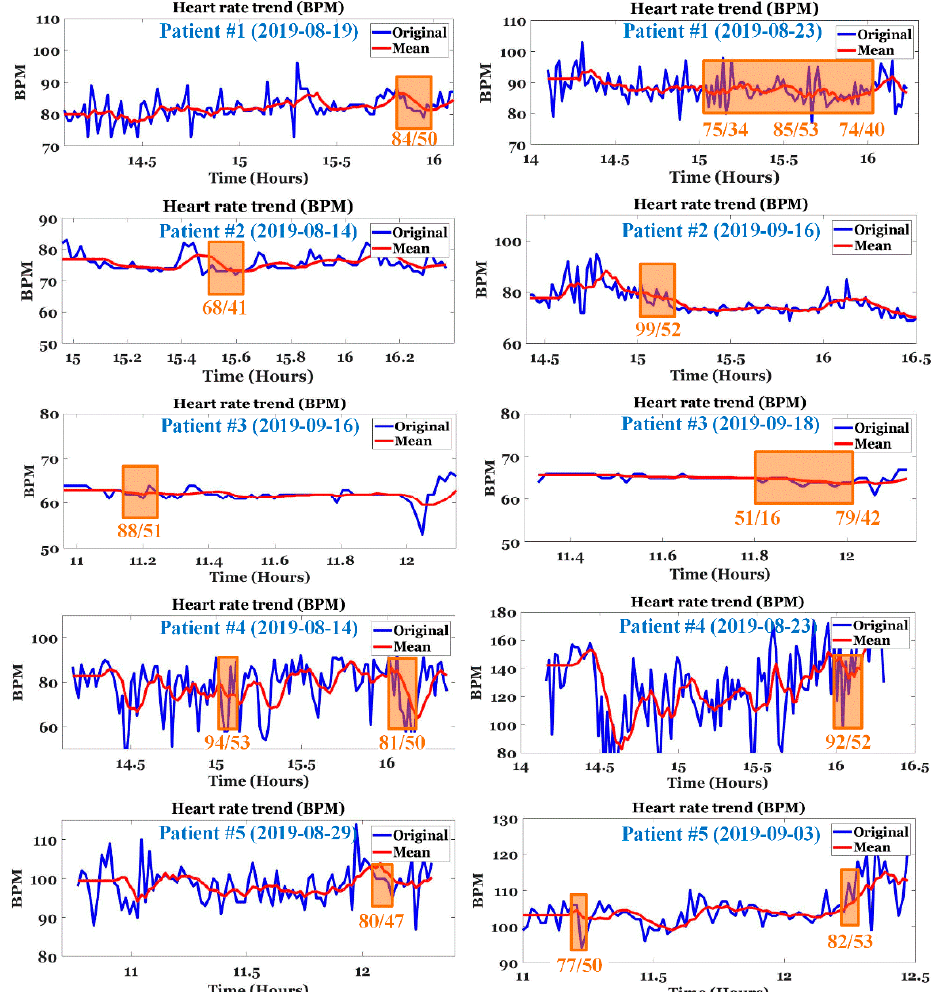
Figure 12. Changes in HR per minute at the onset of IDH in hemodialysis patients. (The square box area indicates the IDH or hypotension period.)